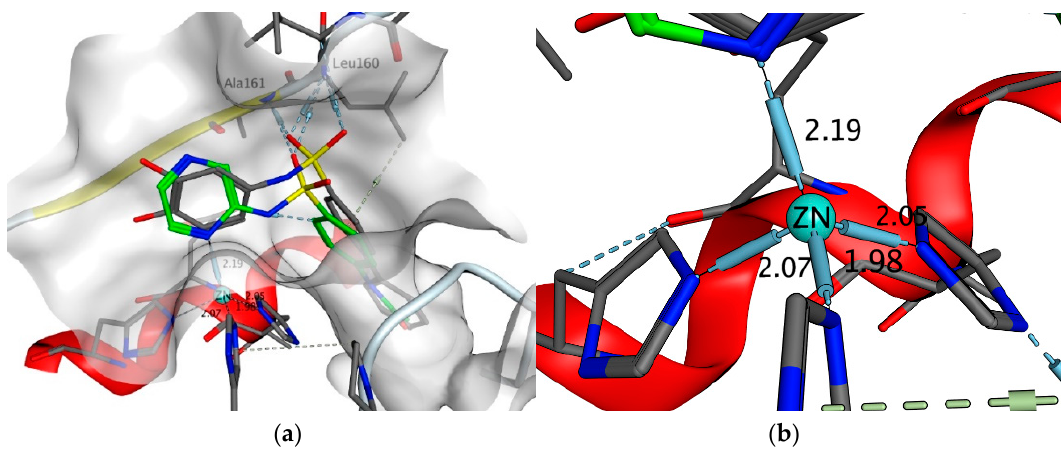
Figure 8. ( a ) Compound 2a (green carbons) docked to MMP-8 (PDB ID: 5h8x) in comparison to the co-crystalized pose of the original catechol ligand (grey carbons). ( b ) Detail presenting interactions between pyrazine nitrogen N1 ′ and Zn 2+ ion coordinated by His residues. (Measurements are in Å).